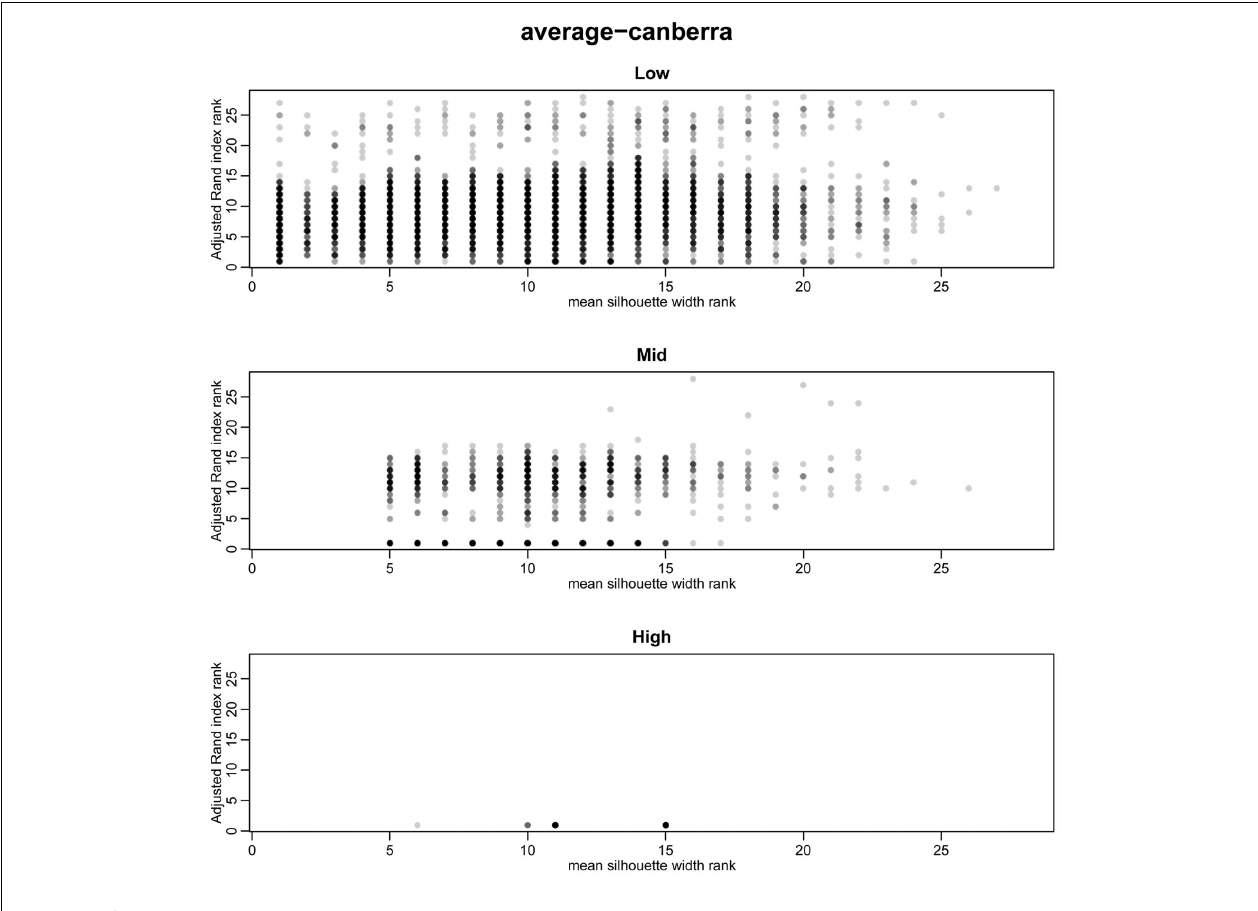
FIGUREA3 | Scatter plots of rand index rank versus mean silhouette width rank across all simulations. A gray scale of dots is used to show the